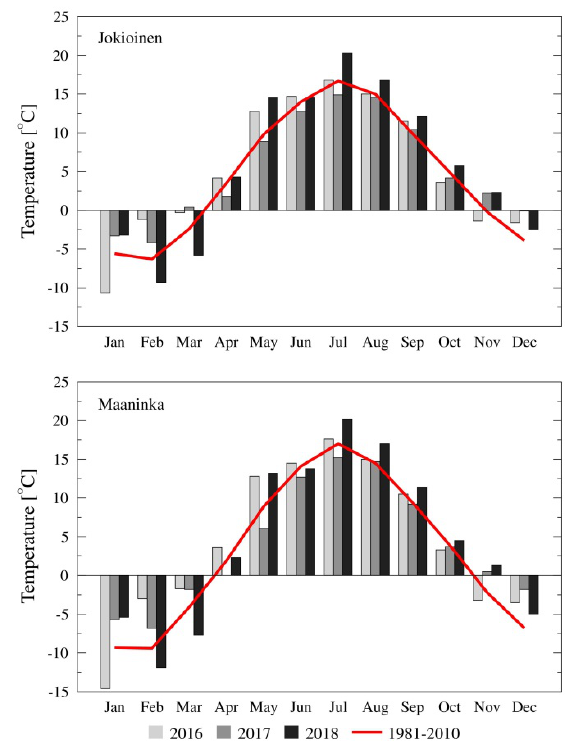
Fig. 1. Mean monthly temperature in the study period (2016–2018) and long-term average for the normal period (1981−2010) in Jokioinen and